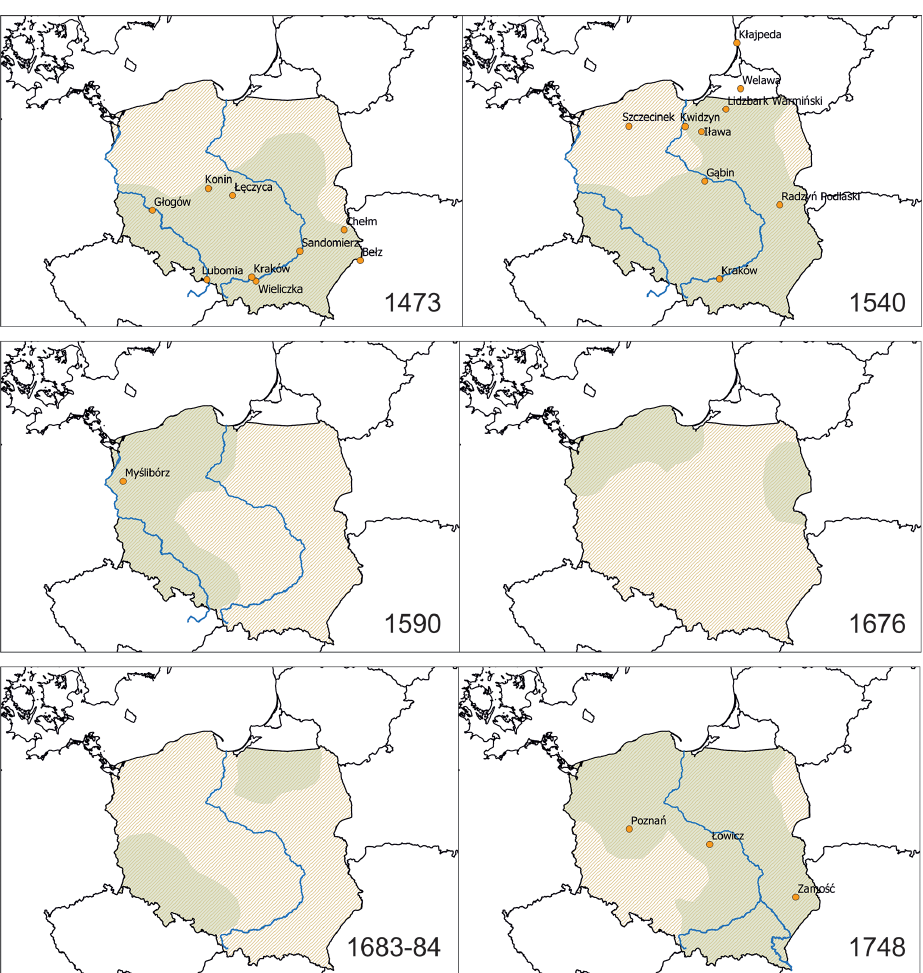
Figure 13. The most severe megadroughts, with spatial coverage (dark colour). Locations of sites and rivers mentioned in Sect. 4.4 and Table 3 are